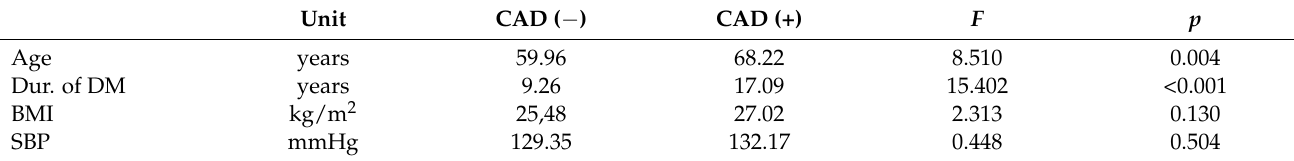
Table 7. Univariate analyses of clinical parameters between the participants with and without a history of CVD in patients with